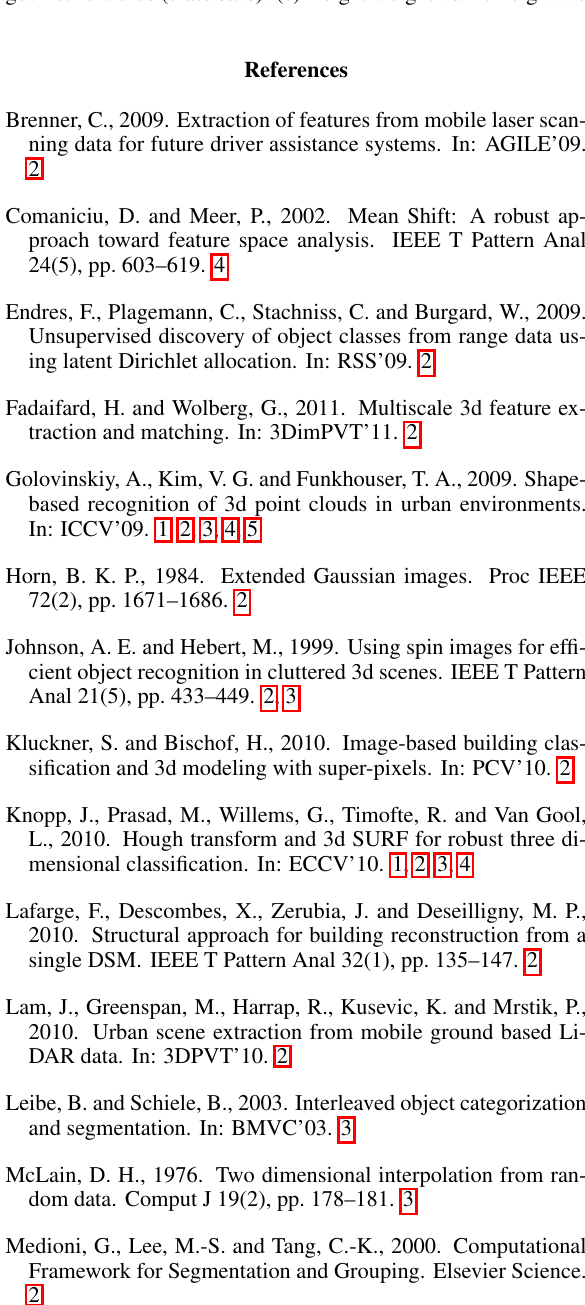
Figure 6: Comparison of detection results for different system settings. (a) Classic vs. modified spin images. (b) Different numbers of geometric words (class cars ). (c) Height weight vs. no height